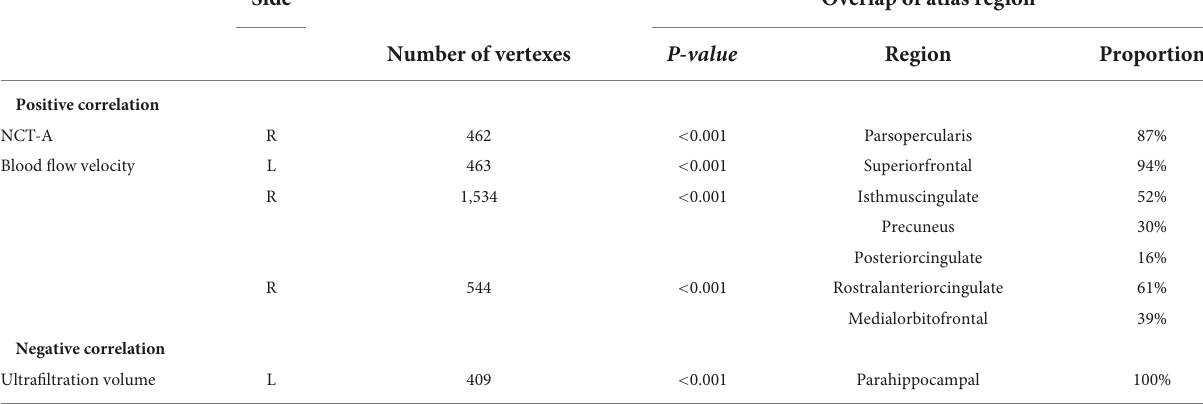
TABLE 5 Correlation between cortical thickness of after HD (HDa) and number connection test-A (NCT-A), Blood flow velocity, ultrafiltration